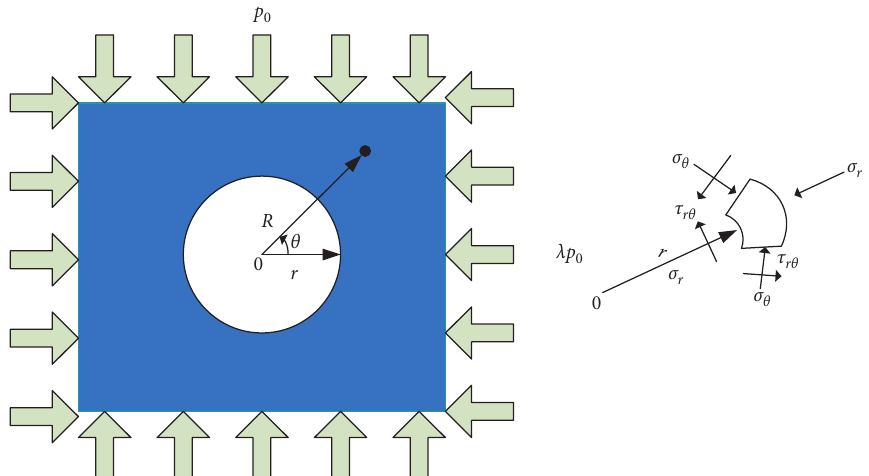
Figure 2: Secondary stress calculation model of surrounding rocks during high-stress rock mass